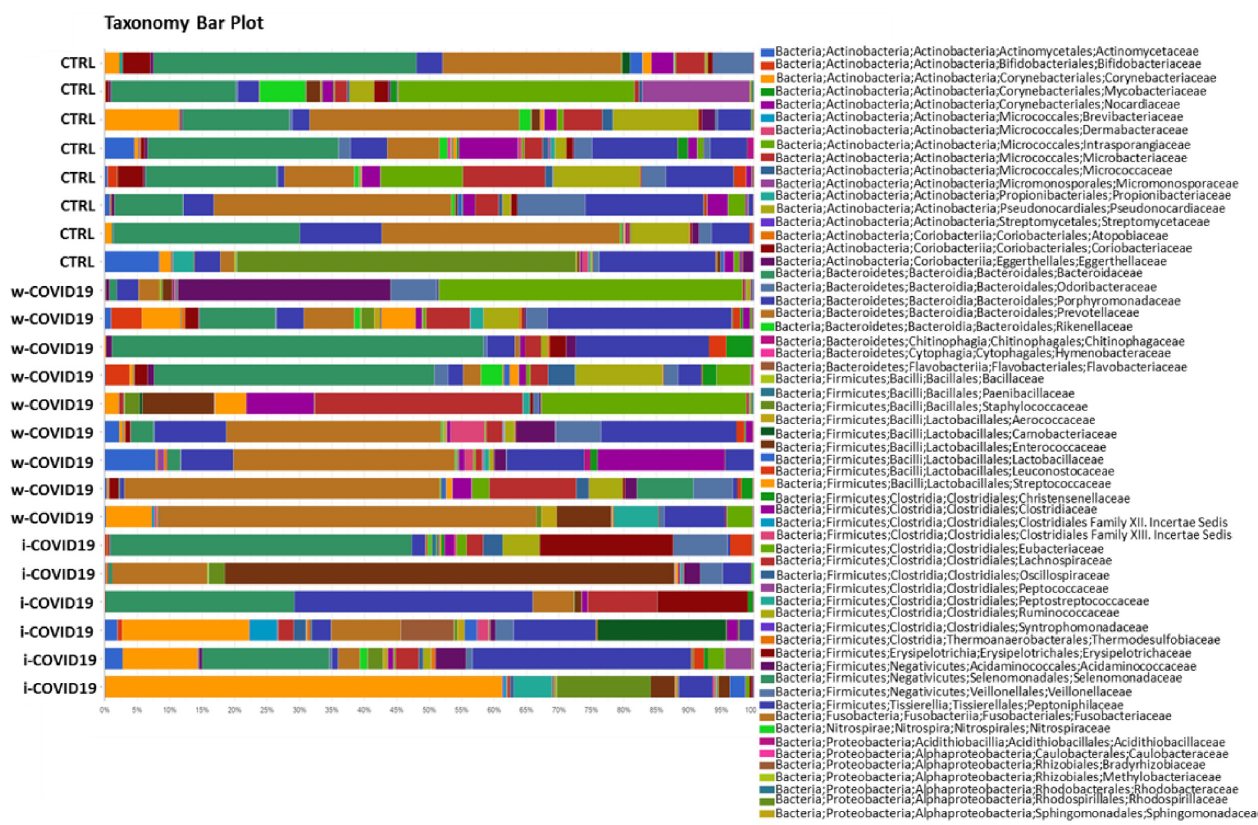
Fig 5. Taxonomy bar plot showing the individual microbiota profile at phylum levels.